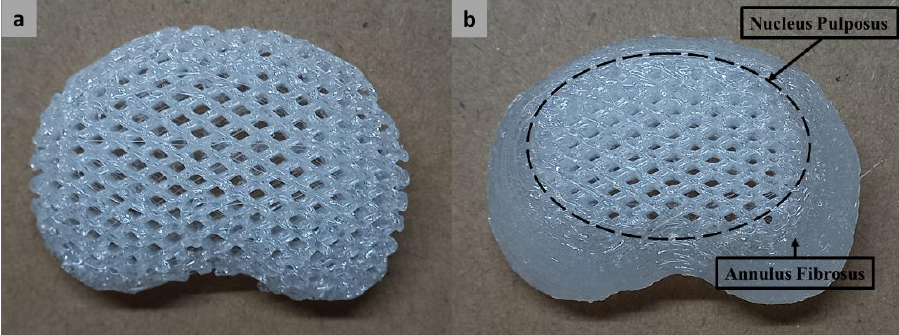
Figure 5. Representative products of FLC-MTDR ( a ) and ABC-MTDR ( b ) made of TPU 87A for the L1L2 segment.